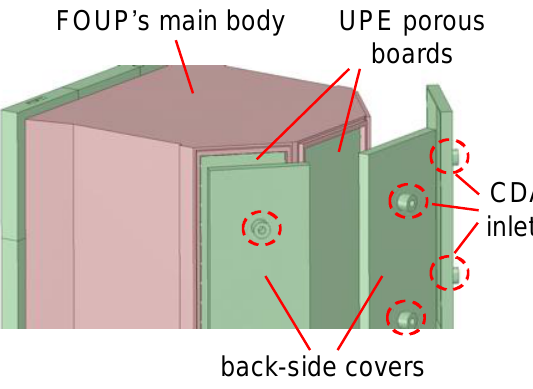
Figure 4. Schematic of a developed FOUP with a panel-purge device. CDA—clean dry air.